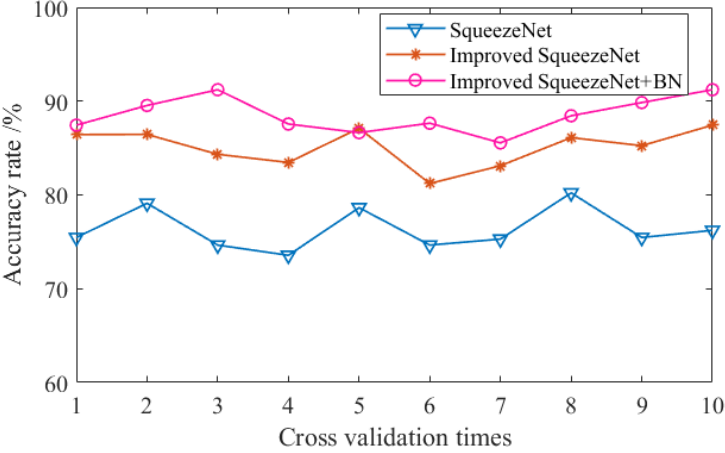
Figure 13. The accuracy rate changes of different SqueezeNet models during 10-fold cross-valida- tion. Table 3. Relief hole target recognition results based on different SqueezeNet models.